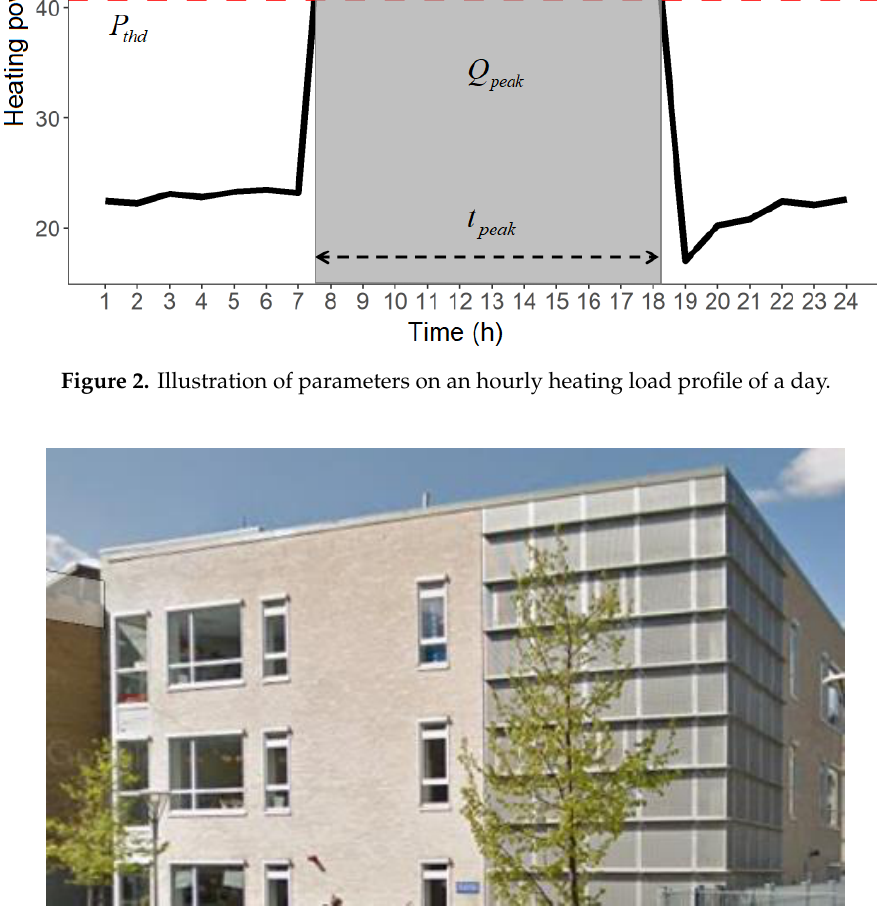
Figure 3. The exterior view of the case building for identifying the peak load shifting potential.